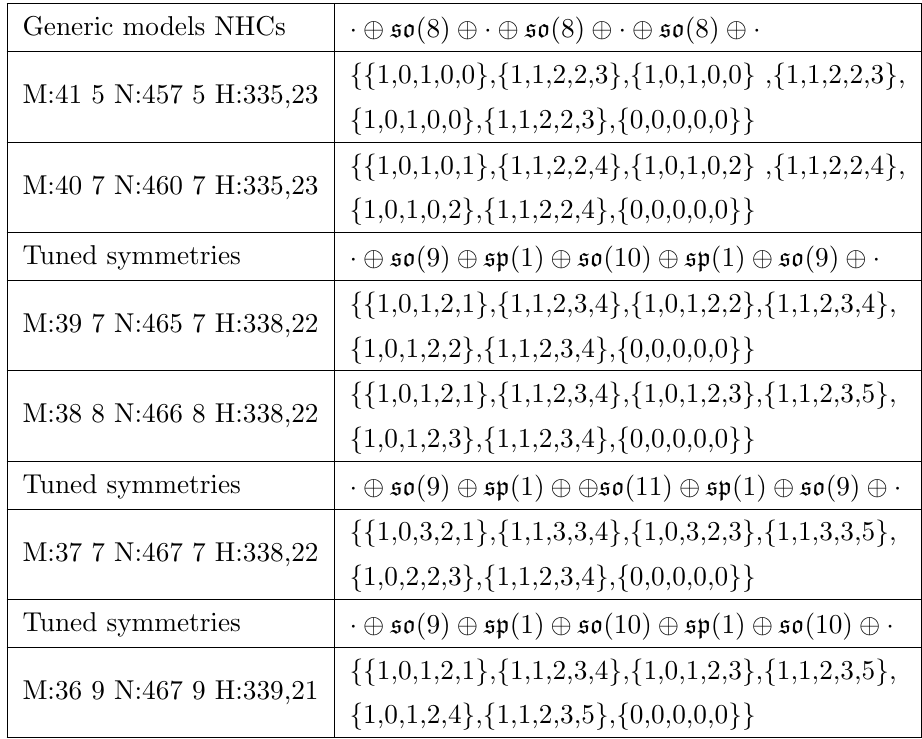
Table 12. An example contrasting the absence and the existence of multiple realizations: successive Tate tunings of generic CYs over the toric base f(cid:0) 12 == (cid:0) 11 == (cid:0) 12 == (cid:0) 12 == (cid:0) 12 == (cid:0) 12 == (cid:0) 12 == (cid:0) 12 == (cid:0) 12 == (cid:0) 12 == (cid:0) 12 ; (cid:0) 1 ; (cid:0) 2 ; (cid:0) 2 ; (cid:0) 3 ; (cid:0) 1 ; (cid:0) 4 ; (cid:0) 1 ; (cid:0) 4 ; (cid:0) 1 ; (cid:0) 4 ; 0 g . The Tate vanishing orders on the last seven curves f(cid:0) 1 ; (cid:0) 4 ; (cid:0) 1 ; (cid:0) 4 ; (cid:0) 1 ; (cid:0) 4 ; 0 g are indicated. All polytope models in the KS database with the Hodge pairs f 225 ; 23 g ; f 338 ; 22 g ; f 339 ; 21 g are listed in each of the three blocks. In models with Hodge pair f 338 ; 22 g , both the weaker and the stronger versions of the tuning of so (10) on the middle (cid:0) 4-curve exist | the weaker version can not correspond to so (9) by the global symmetry constraint on the (cid:0) 4-curve. On the other hand, there is only one model with Hodge pair f 339 ; 21 g , the weaker version of the tuning of so (10) on the last (cid:0) 4-curve does not exist in the KS database | the same Tate tuning gives so (9) on the last (cid:0) 4-curve in the model M:38 8 N:466 8